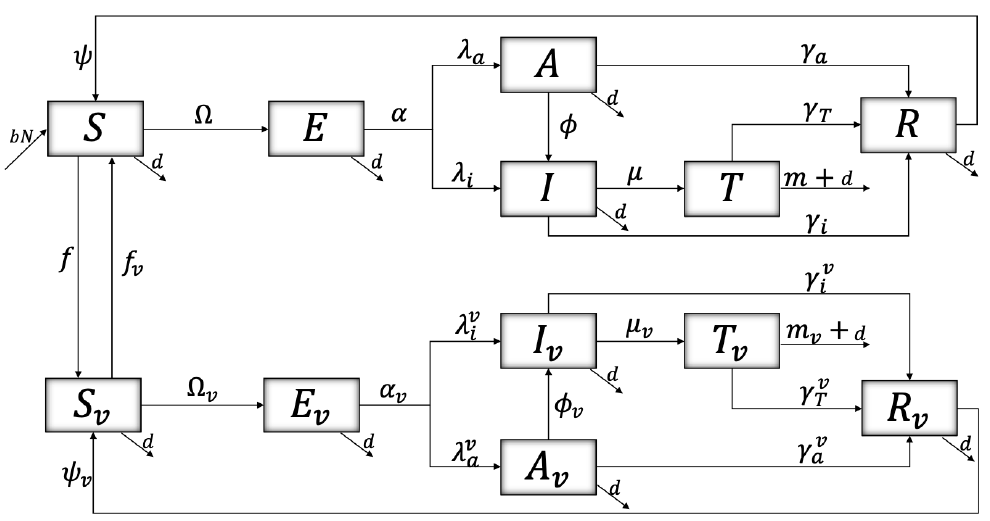
Figure 1. The model is divided into two main groups: (i) the unvaccinated and (ii) the vaccinated, differentiating (ii) from (i) by their v index. The general dynamics of the two groups are similar, except for the associated values at the respective rates. It is assumed that all entering the model are unvaccinated susceptible. Susceptible people ( S and S V ) are infected after encountering an infectious individual, either with symptoms ( I and I v ) or without them ( A and A v ), differing mainly by the respective transmission rates. Once the infection is contracted, it has an incubation period for some time ( E or E v ) to become later infectious ( A , I , A v , or I v ). Asymptomatic people, after a while, may have symptoms. There are individuals with symptoms that need medical intervention ( T or T v ), and some of them might die from the disease ( m or m v ). The recovery of people, whether asymptomatic, with symptoms and of those who need medical intervention, are directed to the R or R v compartment depending on whether (i) or (ii), whose immunity is temporary, becoming susceptible again. Note that Ω = ( β Ω v + β v I ) / N u + δ ( β v a A v + β v I v ) / N u , where N v a A + β i I ) / N u + δ ( β a A v + β i I v ) / N v , v = ( β a A i i and N u correspond to the vaccinated and unvaccinated populations, respectively. The transmission P ∗ P ∗ v rate is dependent on the risk perception ( P ) so that β x = β ∗ x and β v x = β ∗ x , with x ∈ { a , i } . P P v N = N u + N v